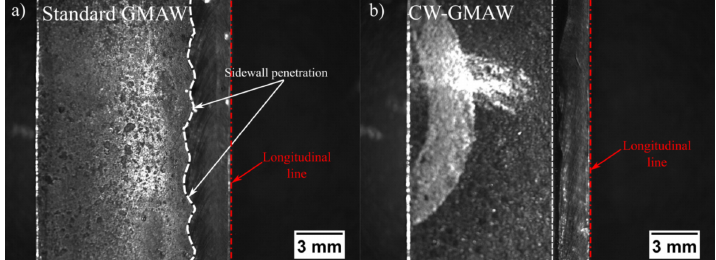
Figure 7. Top view of the sidewall penetration caused by the root pass; the specimens were cut along the longitudinal line (dashed red line): ( a ) standard GMAW; and ( b ) CW-GMAW. Once can note that the specimens were cut along the longitudinal axis of the joint. Note: In ( b ), the mark on its front is a written identification of the sample that could not be